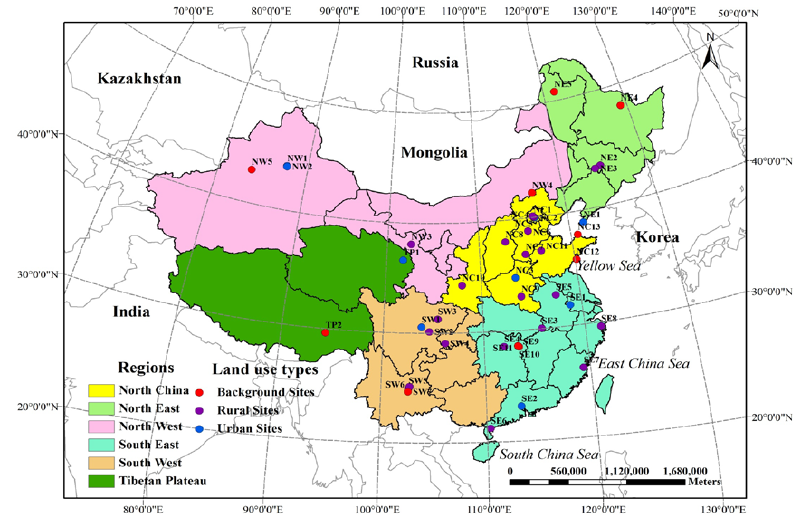
Figure 1. Geographical distribution of the 43 monitoring sites in